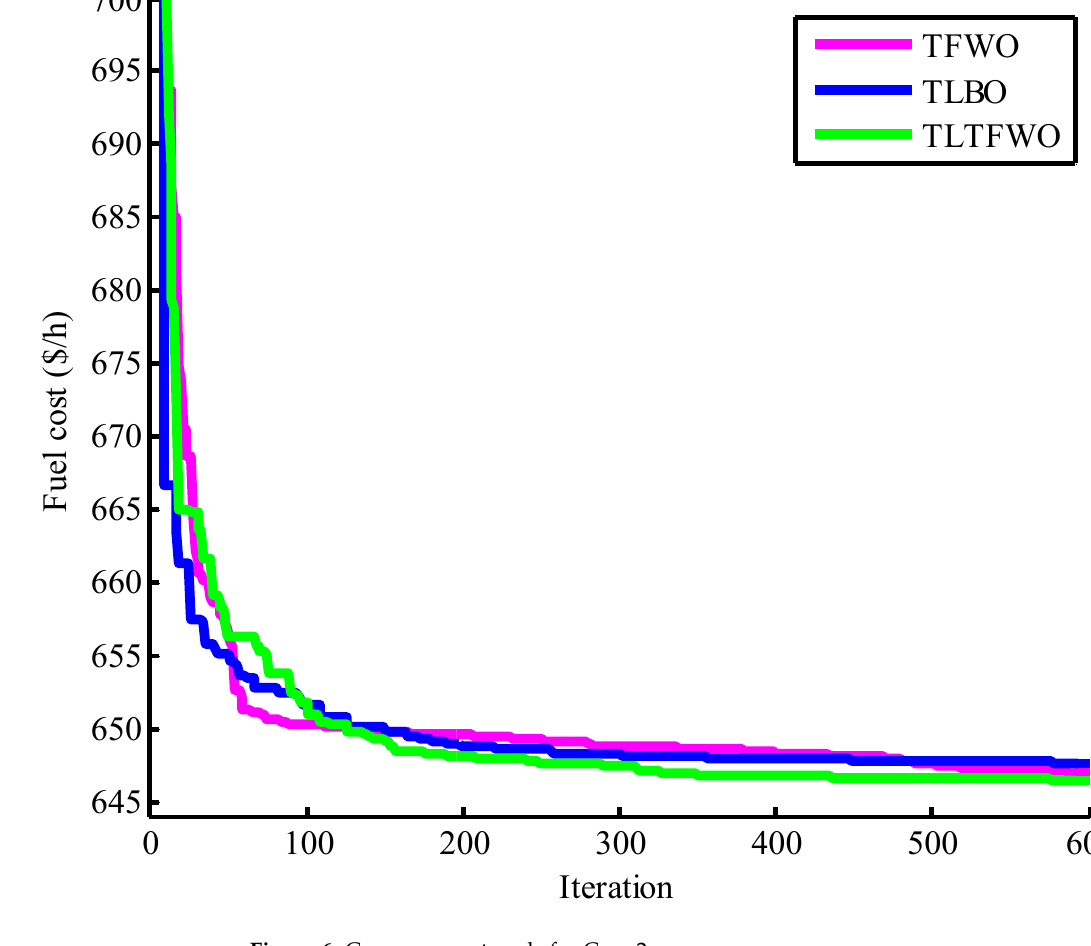
Figure 6. Convergence trends for Case 2.